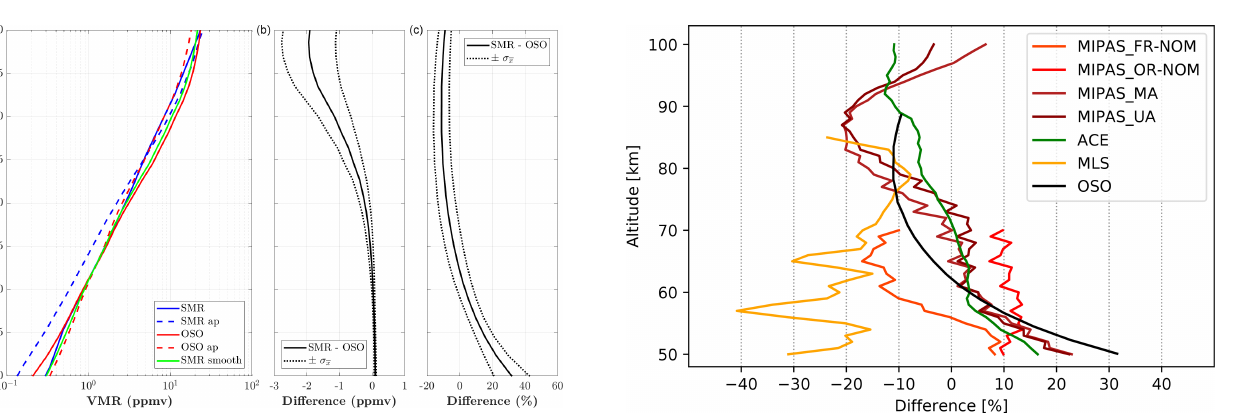
Figure 14. Summary of relative differences between SMR CO con- centrations and the ones measured by all other instruments consid- ered in this study. For the sake of clarity, errors are not